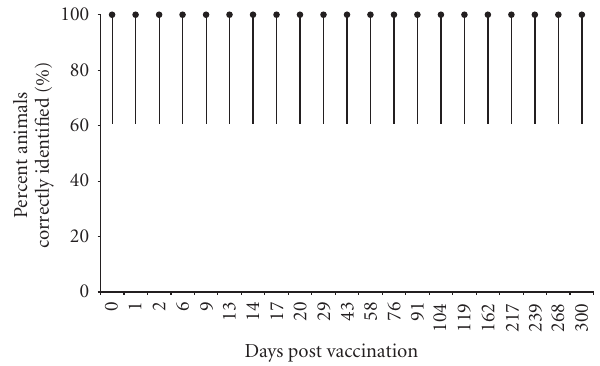
Figure 4: Percent control animals correctly identified by the RB51- CFT and 95% Credibility